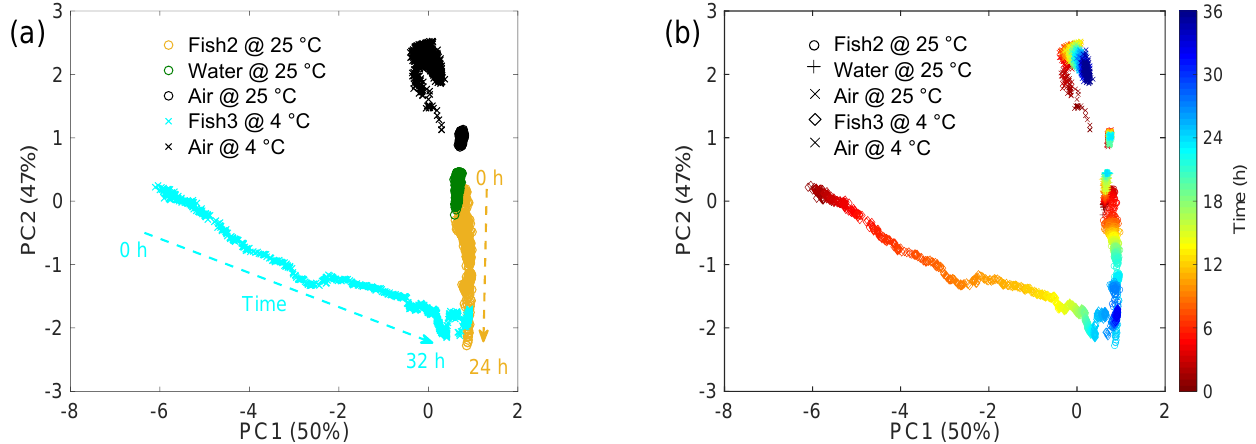
Figure 6. Principal component analysis (PCA) plot showing the time dependence of the device response and its correlation with selected air, water, and fish samples measured at different temper- atures. For the sake of clarity, only five samples are shown; each sample is measured for a period lasting between 24 and 36 h. ( a ) Colors and symbols are used to distinguish different samples and temperatures, respectively. Dashed arrows indicate the time direction for fish samples. ( b ) The color-bar identifies the measurement time for all samples, symbols identify different samples.